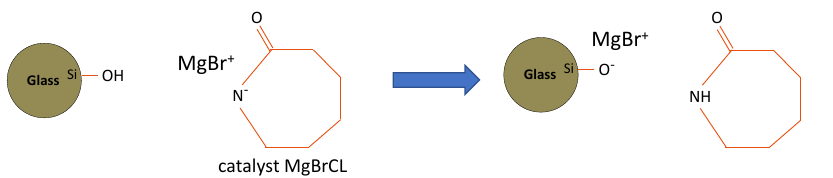
Figure 1. Deactivation, by surface hydroxyls, of the catalyst used for the synthesis of PA6 by anionic ring-opening